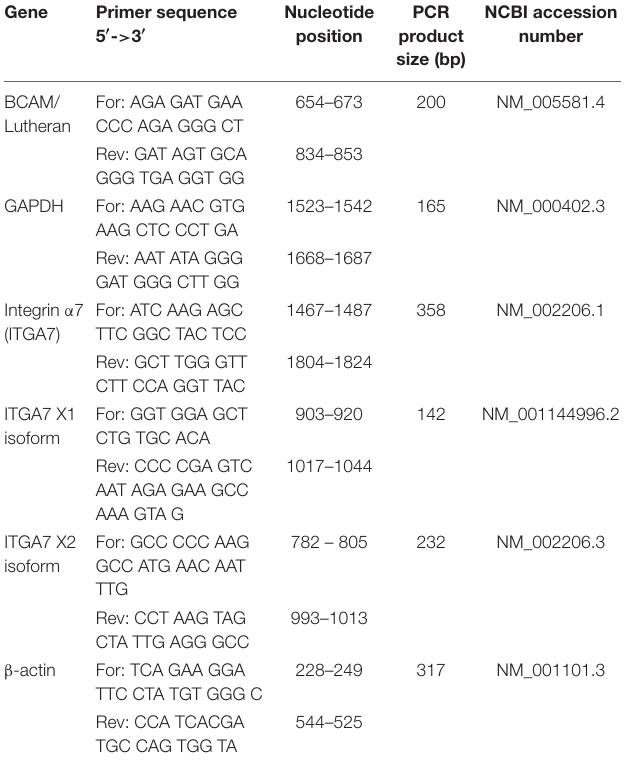
TABLE 1 | Forward and reverse primer sequences.